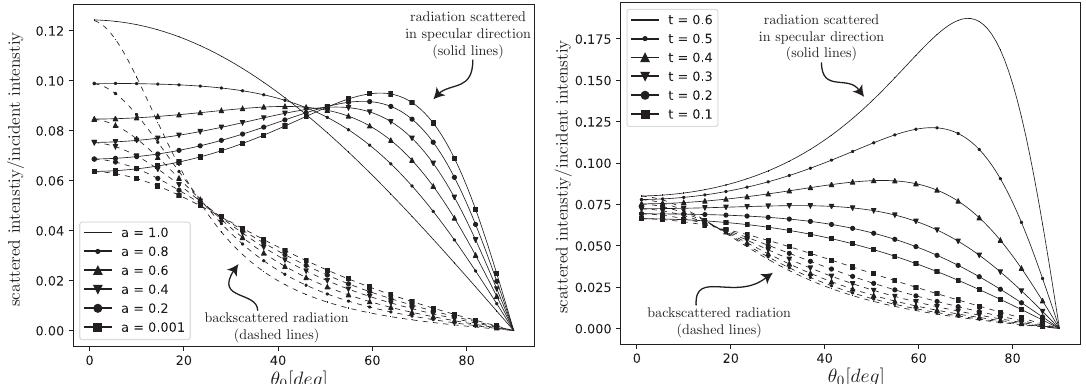
Figure 5. Impact of a change in the a -parameter ( left ) ( t = 0.4, N = 0.2) and the t -parameter ( right ) ( a = 0.4, N = 0.2) on the specular- and backscattered intensity of the BRDF representation defined (cid:16) (cid:17) I s / I inc = cos ( θ ) BRDF ( θ , φ ) in (10). ∗